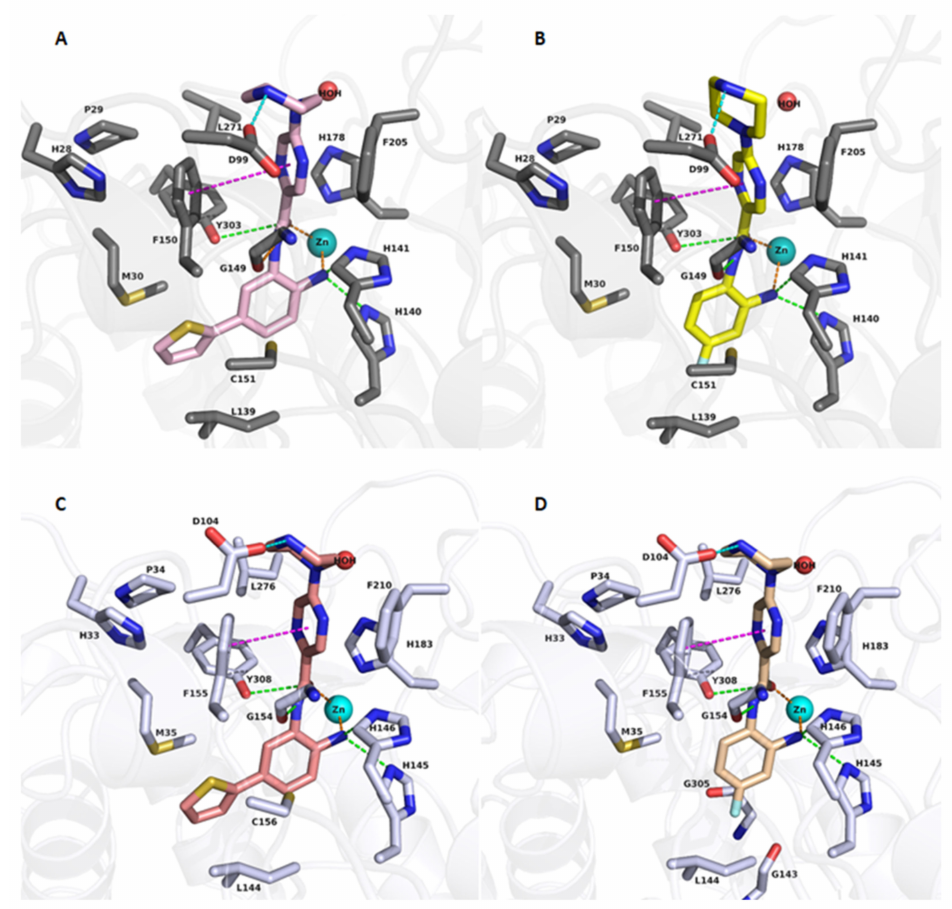
Figure 4. Docking poses of 29b ( A , pink colored sticks), 23a ( B , yellow colored sticks), in HDAC1 (PDB ID 4BKX) and 29b ( C , salmon colored sticks), 23a ( D , creme colored sticks) in HDAC2, (PDB ID 4LY1). Hydrogen bonds (green dashed lines), metal coordination (orange dashed lines), ionic interactions (cyan dashed lines) and aromatic interactions (magenta dashed lines) between inhibitors and the protein are shown. Relevant residues are shown in stick representation with dark grey carbon atoms in HDAC1 and white carbon atoms in HDAC2. The zinc ion is shown as a cyan colored sphere. The conserved water molecule is shown as a red sphere. The zinc-carbonyl oxygen and zinc-amino distances, respectively, are 2.43 Å and 2.41 Å for 29b/HDAC1, 2.39 Å and 2.58 Å for 23a/HDAC1, 2.22 and 2.28 Å for 29b/HDAC2, 2.23 Å and 2.41 Å for